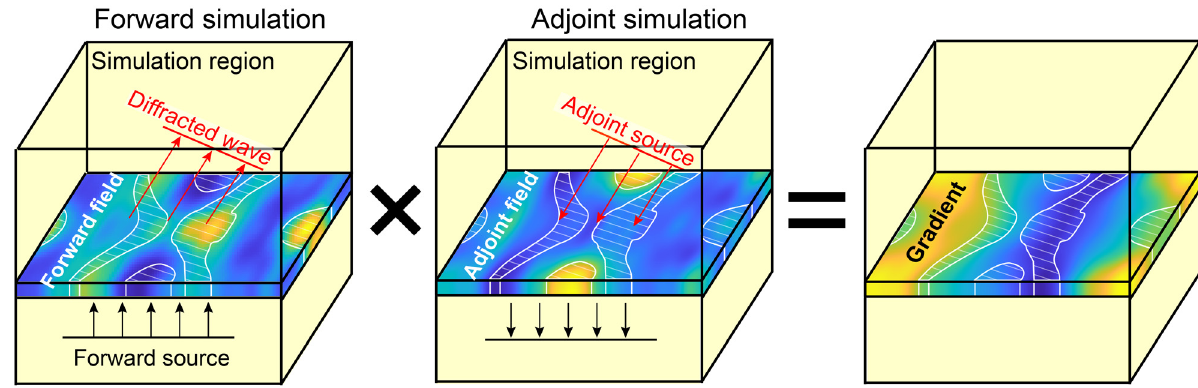
Figure 8: Conceptual image of adjoint method formulation for a beam deflector design problem. The simulation region is shown in half- transparent yellow. White shaded regions indicate regions filled with materials. Color contours represent the forward field (left), adjoint field (middle), and gradient distributions (right). (Left) In a forward simulation, a forward source (black arrows) is incident to evaluate FoM and forwardfield.Adiffractedwavepropagatingtowardthetargetdirectionisindicatedasredarrows.(Middle)Inanadjointsimulation,anadjoint source(redarrows)is incidentto evaluatetheadjointfield. (Right)FoM gradients areobtainedthroughprocedures includingmultiplicationof the forward field and the adjoint field, providing guidelines on how material distribution should change to yield better